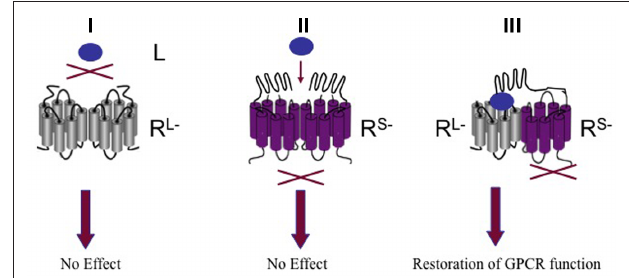
FiGuRE 3 | G protein-coupled receptors oligomerization by intermolecular functional complementation of mo mutant receptors. (i) Oligomerization of ligand binding deficient receptor mutant (R L − ) does not trigger GPCR function. (ii) Oligomerization of signaling deficient receptor mutant (R s − ) does not trigger GPCR function. (iii) Co-expression of R L − and R s − restores GPCR function. L;